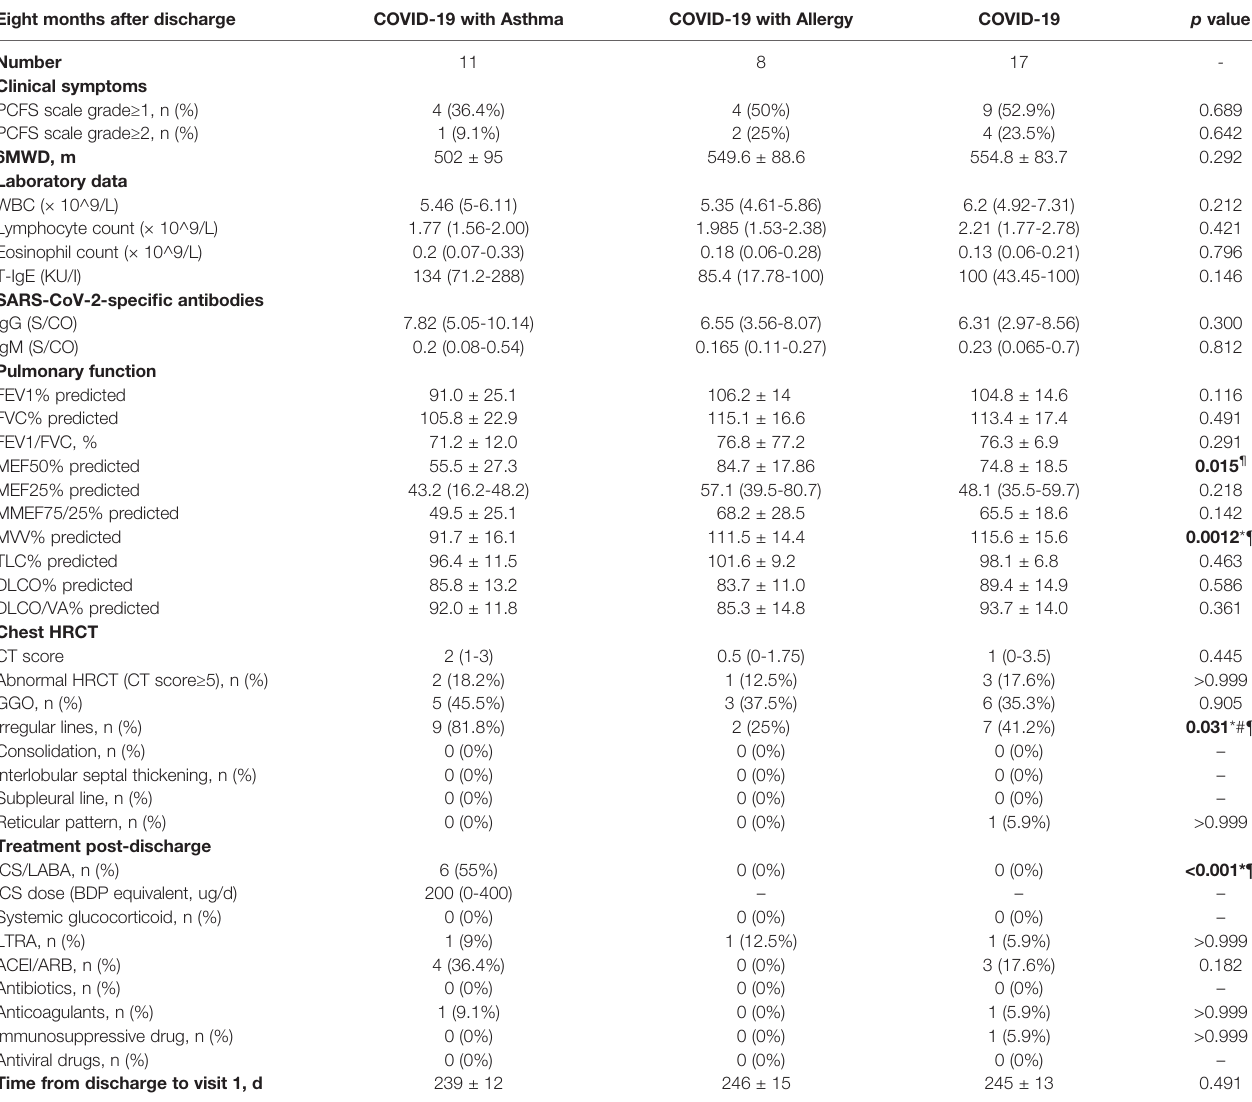
TABLE 2 | Characteristics of COVID-19 survivor with/without asthma or allergy at 8-month follow-up. Eight months after